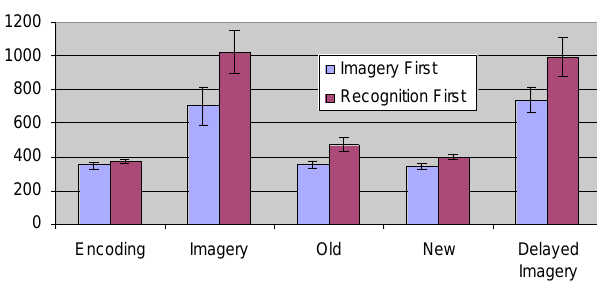
Figure 6: Differences in average fixation durations be- tween the two Tasks and between phases of the course of the